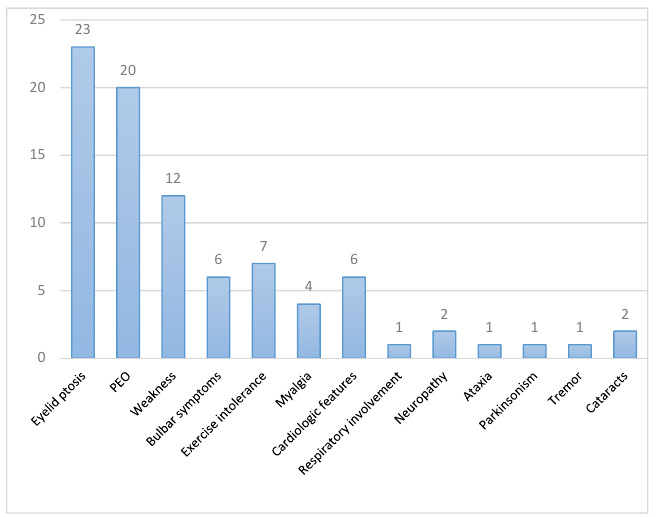
Figure 1. Clinical findings of the 25 patients in our series. Each bar represents the number of patients presenting a specific clinical feature. PEO: progressive external ophthalmoplegia. Two patients presented features suggestive of polyneuropathy (8%): a 28-year-old man (patient 5) with mildly reduced SNAP amplitude in lower limbs, although asympto- matic, and patient 3 with a highly suggestive clinical picture without electrophysiological tests performed. This latter patient also presented gait ataxia which made walking aid necessary. Other less common findings observed were parkinsonism and essential tremor, found in one patient each, and two related patients (24 and 25) developed cataracts at the ages of 48 and 50 years with no other known associated risk factors. Based on the clinical phenotype at initial evaluations, nine patients (36%) were ini- tially misdiagnosed as seronegative myasthenia gravis due to the ocular findings despite the lack of fatigability on examination or other supportive paraclinical data. Three of them, who associated extraocular symptoms, received specific treatment for myasthenia gravis (see Table 1) with no clinical improvement. Another frequently considered alternative diagnosis before confirmation of TWNK mutations was oculopharyngeal muscular dystrophy (OPMD) in five patients (20%). 3.2. Complementary Tests All tests were assessed as standard-of-care clinical procedures. From 18/25 patients with available data, 5/18 patients showed CK levels above the upper limit of the reference (28%), with a mean value of 278 U/L. Markers related to mitochondrial dysfunction were also studied, such as lactate and the more specific and sensitive GDF-15, the latter only recently available in our center. Mild hyperlactacidemia was found in three out of six tested patients (3.24–3.7 mmol/L). Serum GDF-15 levels could be determined only in 3/25 patients, being elevated in two (1454 pg/mL in patient 5 and 2727 pg/mL in patient 6) and normal in one (991 pg/mL in patient 2). Results were adjusted according to age. Patient 2, unlike the others, did not have clinical data of muscular involvement additional to PEO.